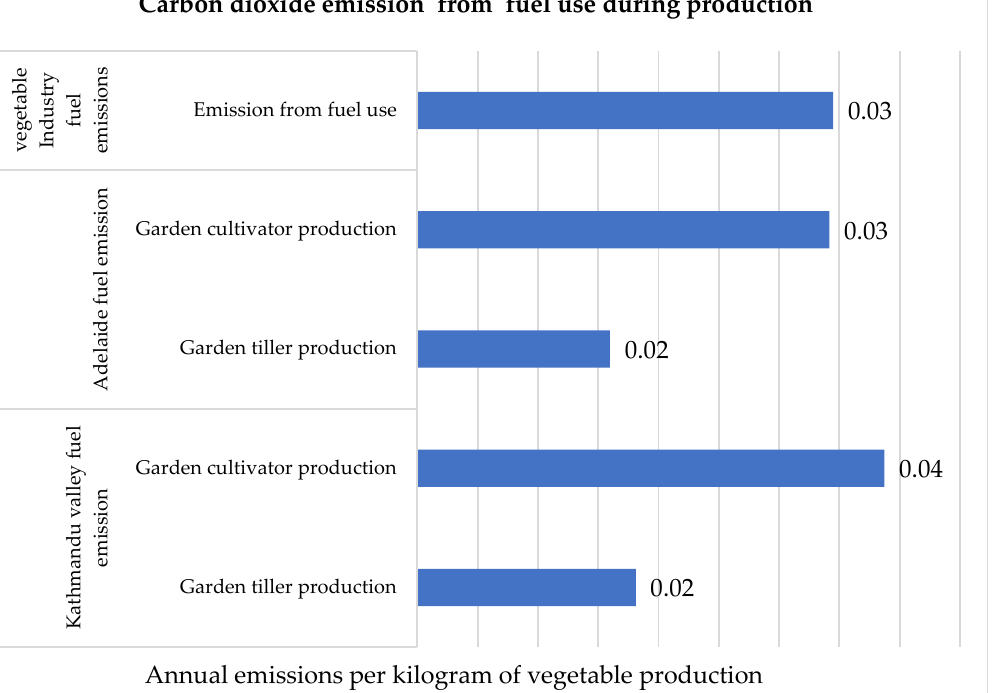
Figure 10. Comparison of CO 2 emission from fuel use between the sites and the Australian vegetable industry.